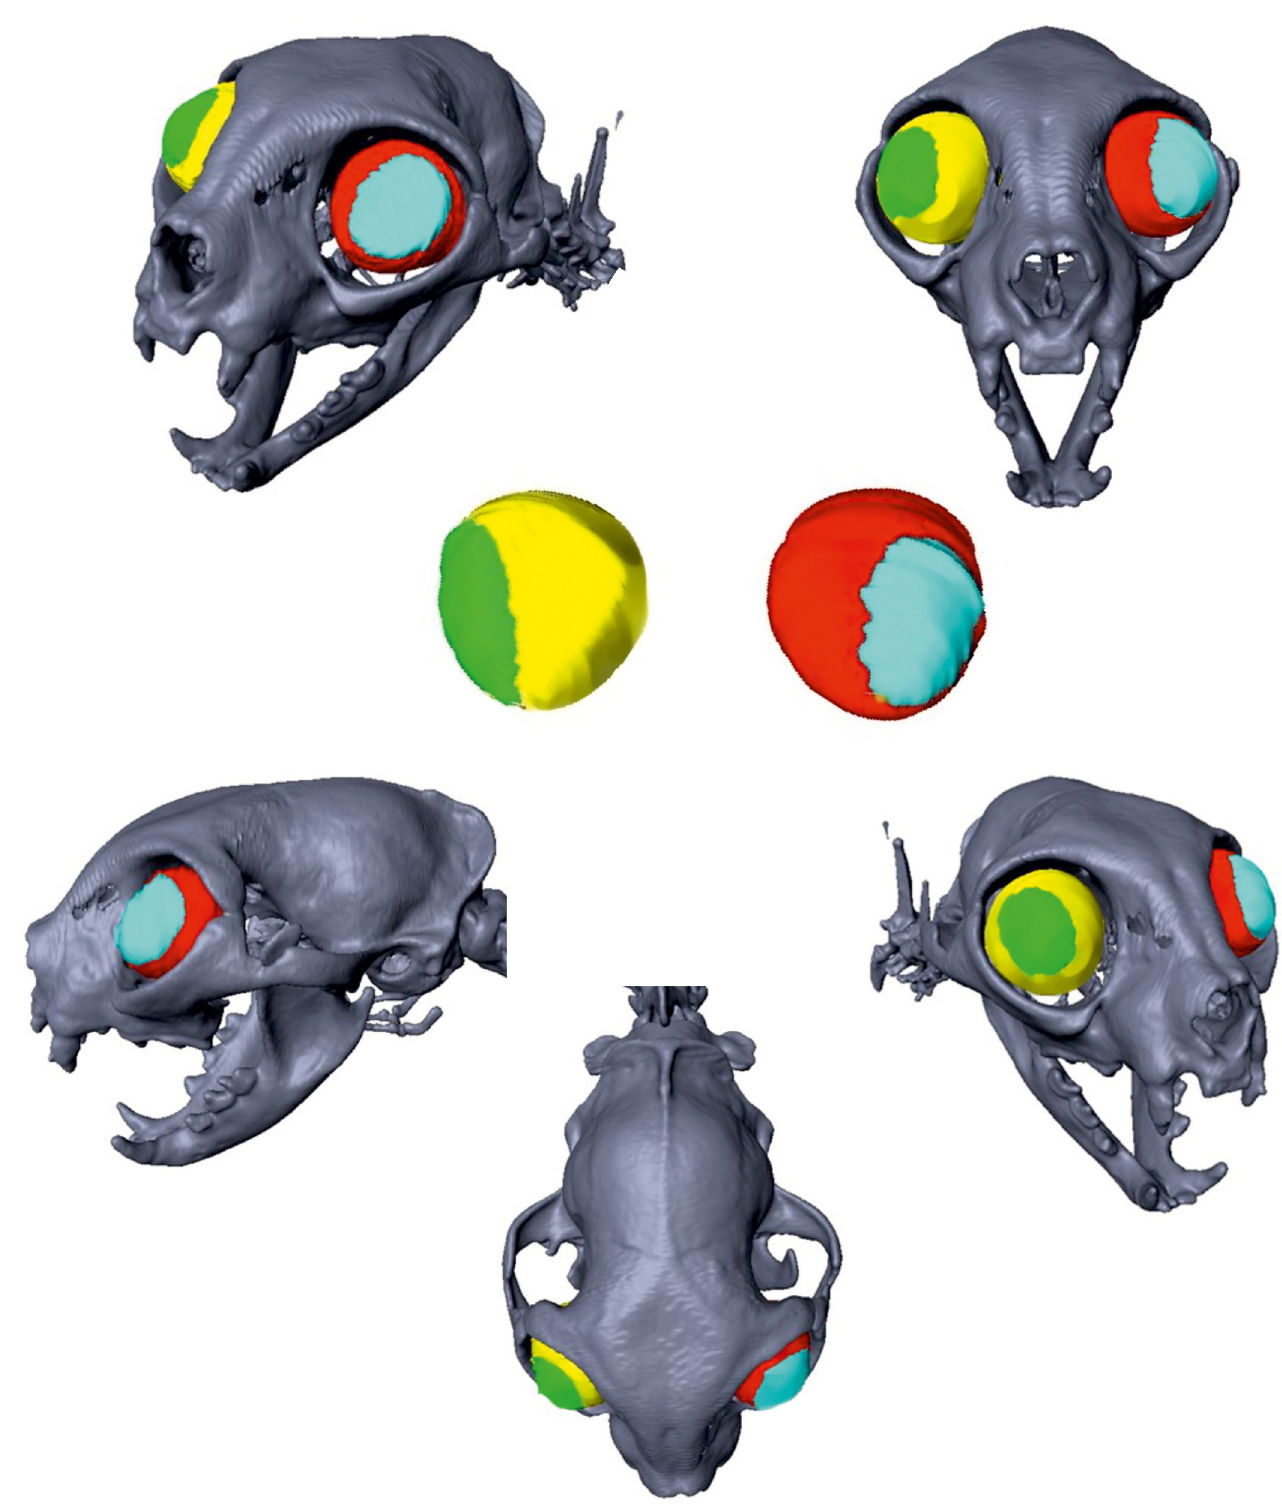
Fig 12. Reconstruction of the extra-orbital part of the eye globes of a Domestic shorthair cat. Three-dimensional skull reconstructions of a Domestic shorthair cat. The different parts of the eye globes are marked in different colours: yellow = intra-orbital part of the right eye; green = extra-orbital part of the right eye; red = intra-orbital part of the left eye; blue = extra-orbital part of the left eye.